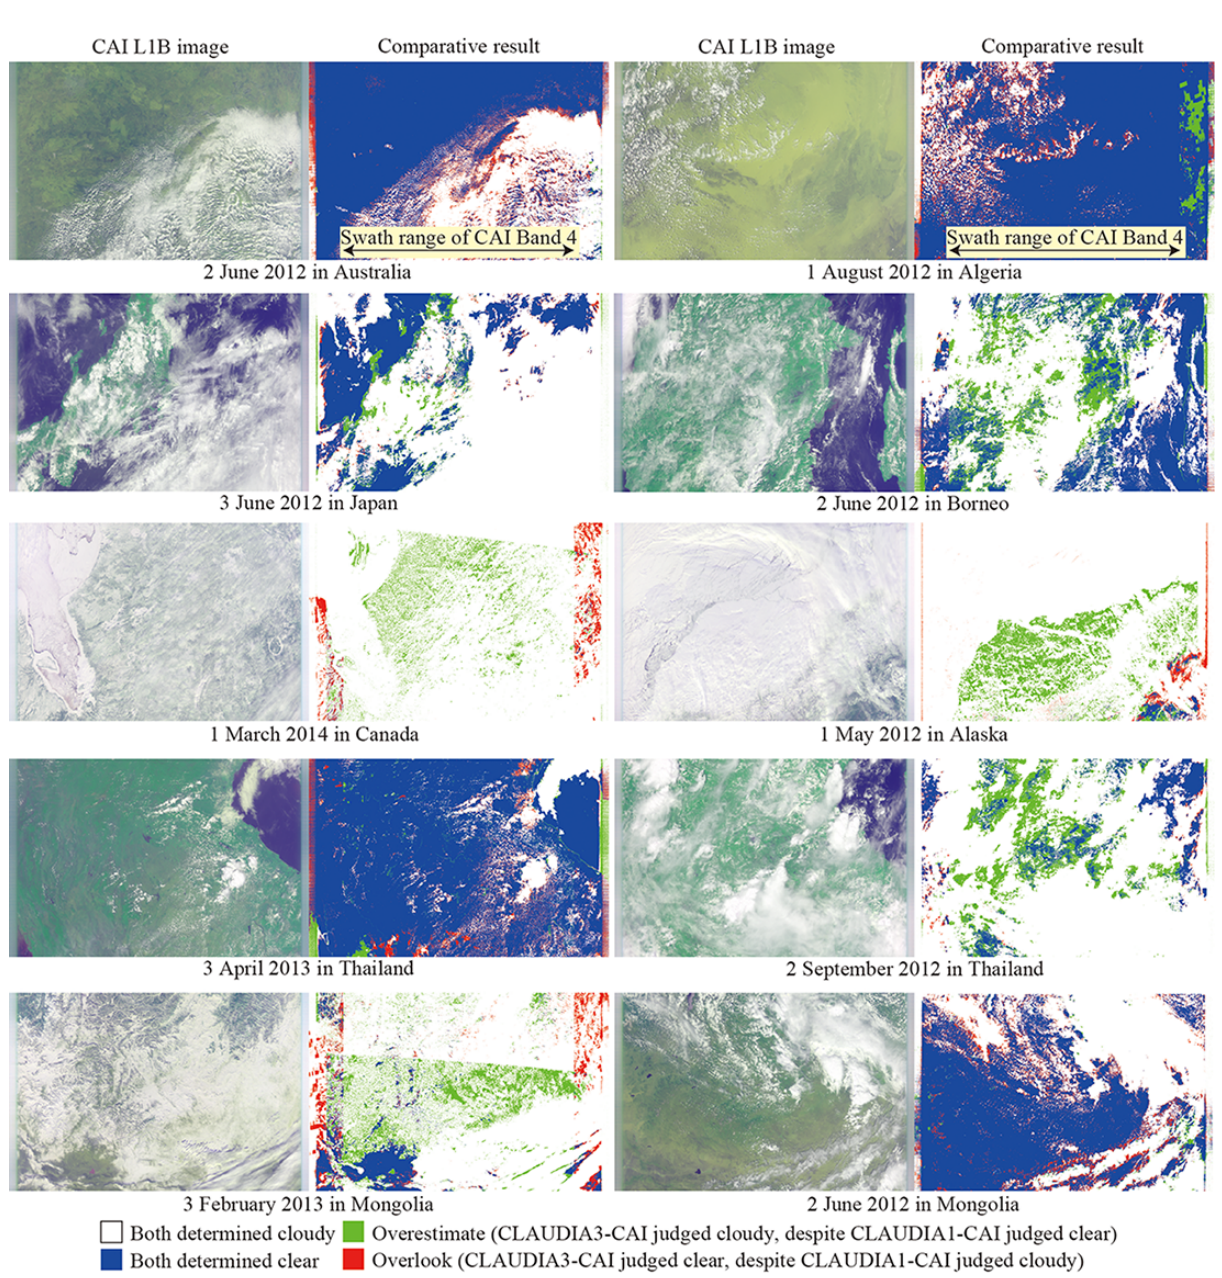
Figure 10. CAI L1B images (R: Band 2, G: Band 3, B: Band 1) and comparative results of CLAUDIA1–CAI and CLAUDIA3–CAI for various land cover